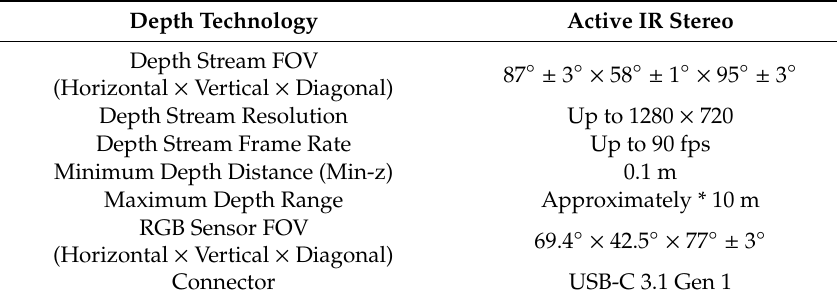
Table 1. RealSense D435 camera specifications.